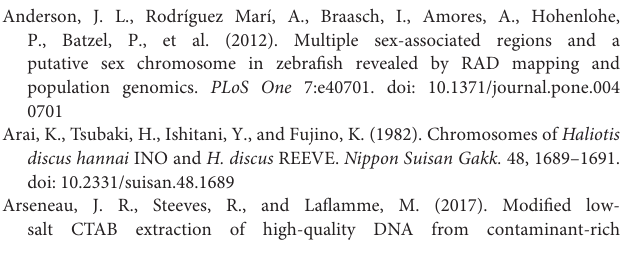
Supplementary Table 1 | Water quality parameter of larval rearing tank of F1 progeny. Supplementary Table 2 | Trait data of 96 F1 progeny. Supplementary Table 3 | Summary of Reference genome sequence of Pacific abalone.